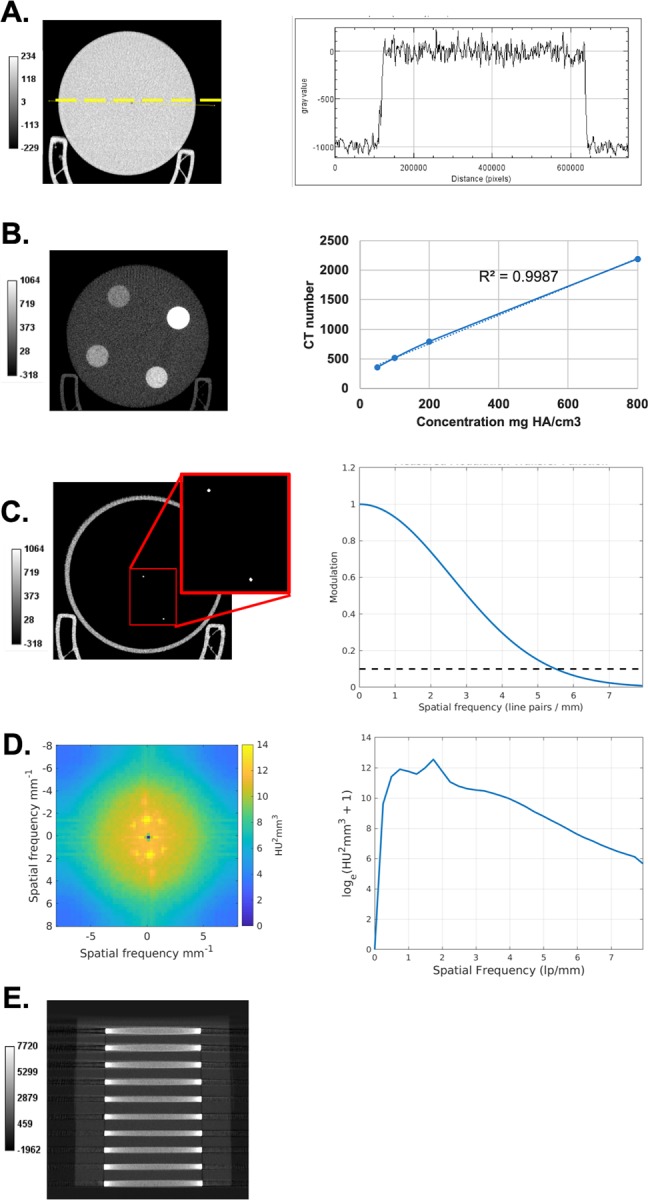
Phantom assessment of the micro-CT scanner performance.Shown is a slice and a line profile through the water phantom (A). The CT linearity was obtained by scanning a phantom containing 4 inserts with various concentrations of calcium hydroxyapatite (B). The spatial resolution was assessed with a wire phantom (C). Shown also is the image and the radial profile of NPS obtained in the water phantom (D). Finally, a coronal slice and a line profile of the multi-layer Defrise phantom is shown (E). No substantial cone beam artifacts are present.